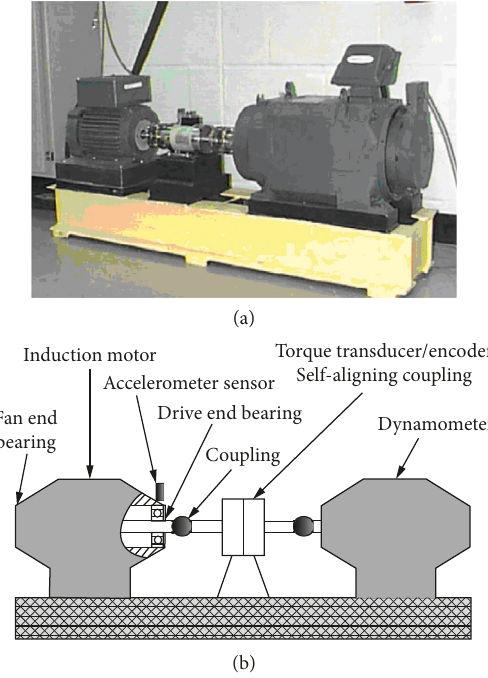
Figure 11: The schematic diagram of roller bearing testbed